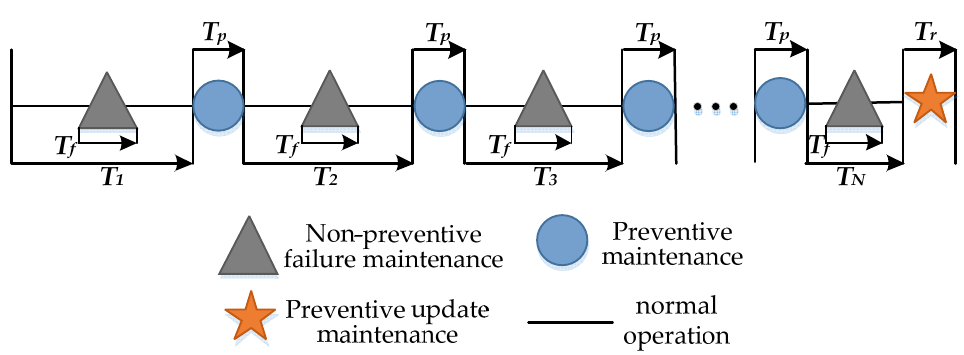
Figure 2. Schematic diagram of a single ‐ component preventive maintenance strategy.